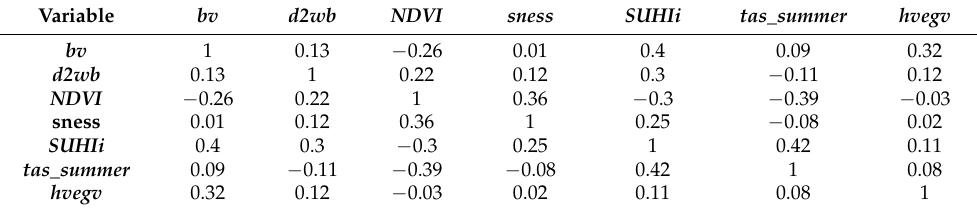
Table 1. Predictor variable correlation matrix (Pearson’s correlation coefficients).